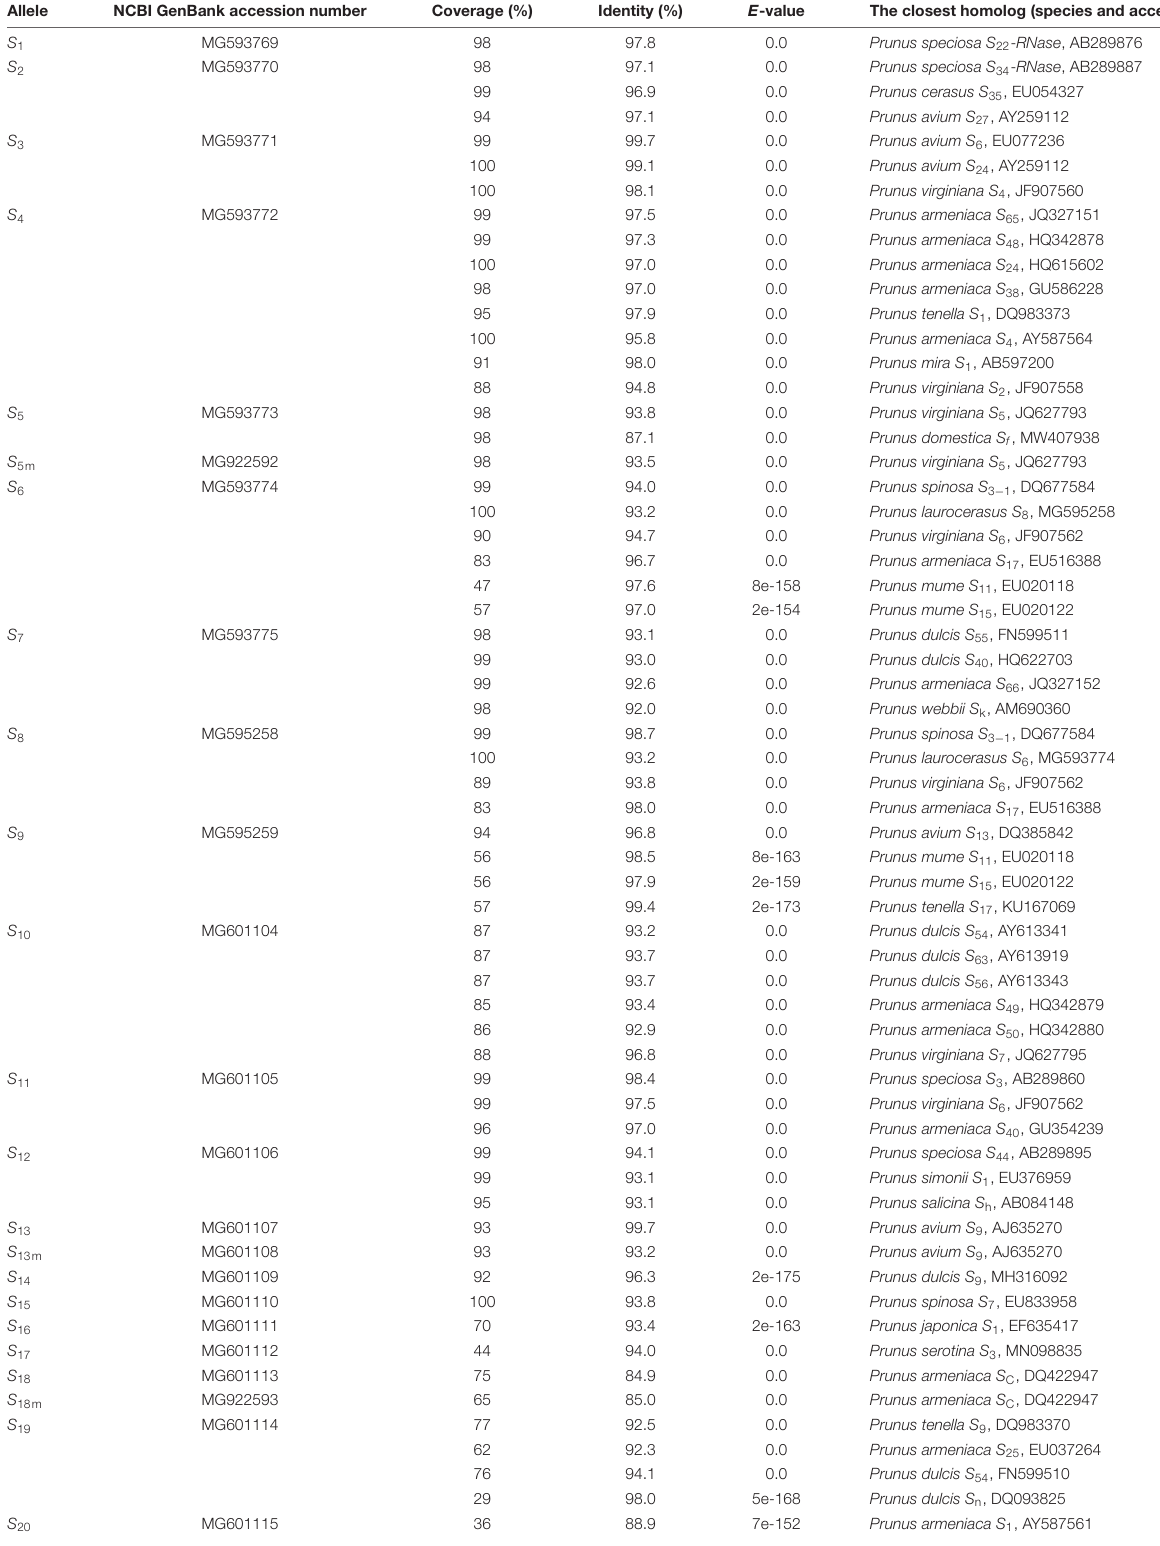
TABLE 1 | The results of the BLASTN analysis of Prunus laurocerasus putative S-RNase alleles sequenced in this work, their corresponding NCBI nucleotide sequence database accession number, percentage of query coverage and identity, the E -value of alignment score and the closest homologs (species name, allele label, and accession